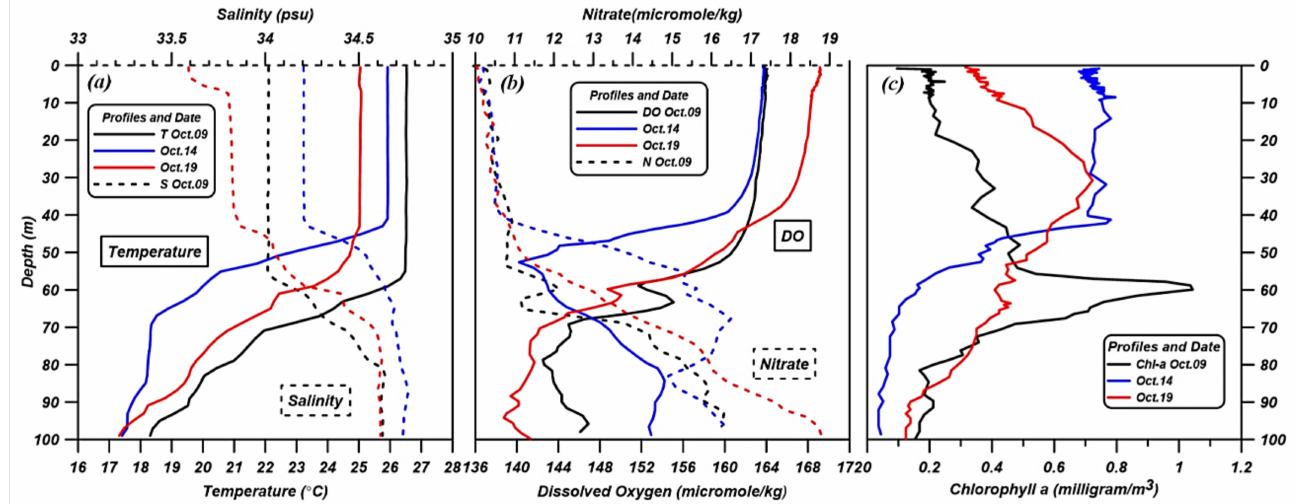
Figure 10. Depth-integrated ( a ) temperature ( ◦ C, solid) and salinity (psu, dotted), ( b ) dissolved oxygen ( µ mol/kg, solid) and nitrate ( µ mol/kg, dotted), and ( c ) Chl-a (mg/m 3 , solid) in the upper 100 m depth observed by Code 2,902,754 BCG Argo float before (C1; 9 October), a day after